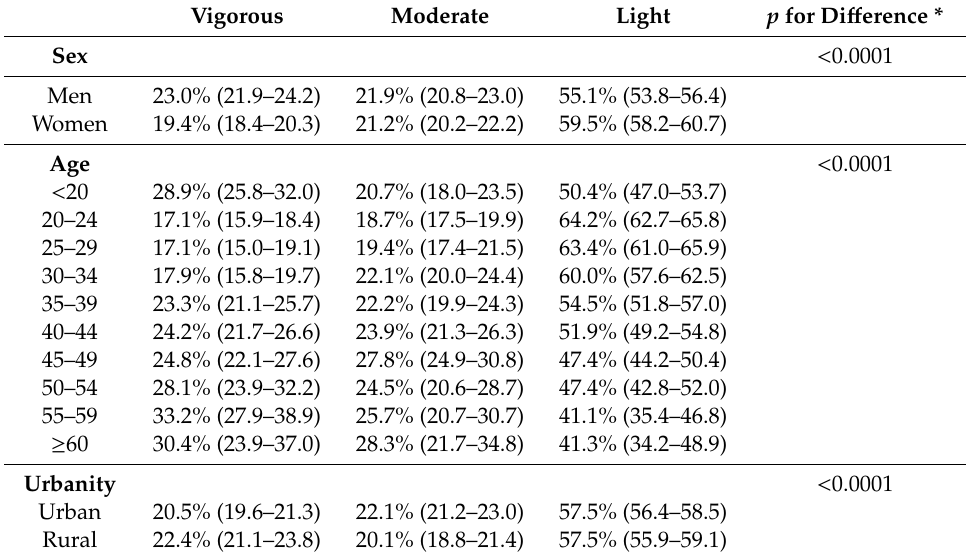
Table 2. Intensity levels of physical activity stratified by sex, age, and urban or rural residence during home quarantine induced by COVID-19 outbreak in mainland China, 2020.